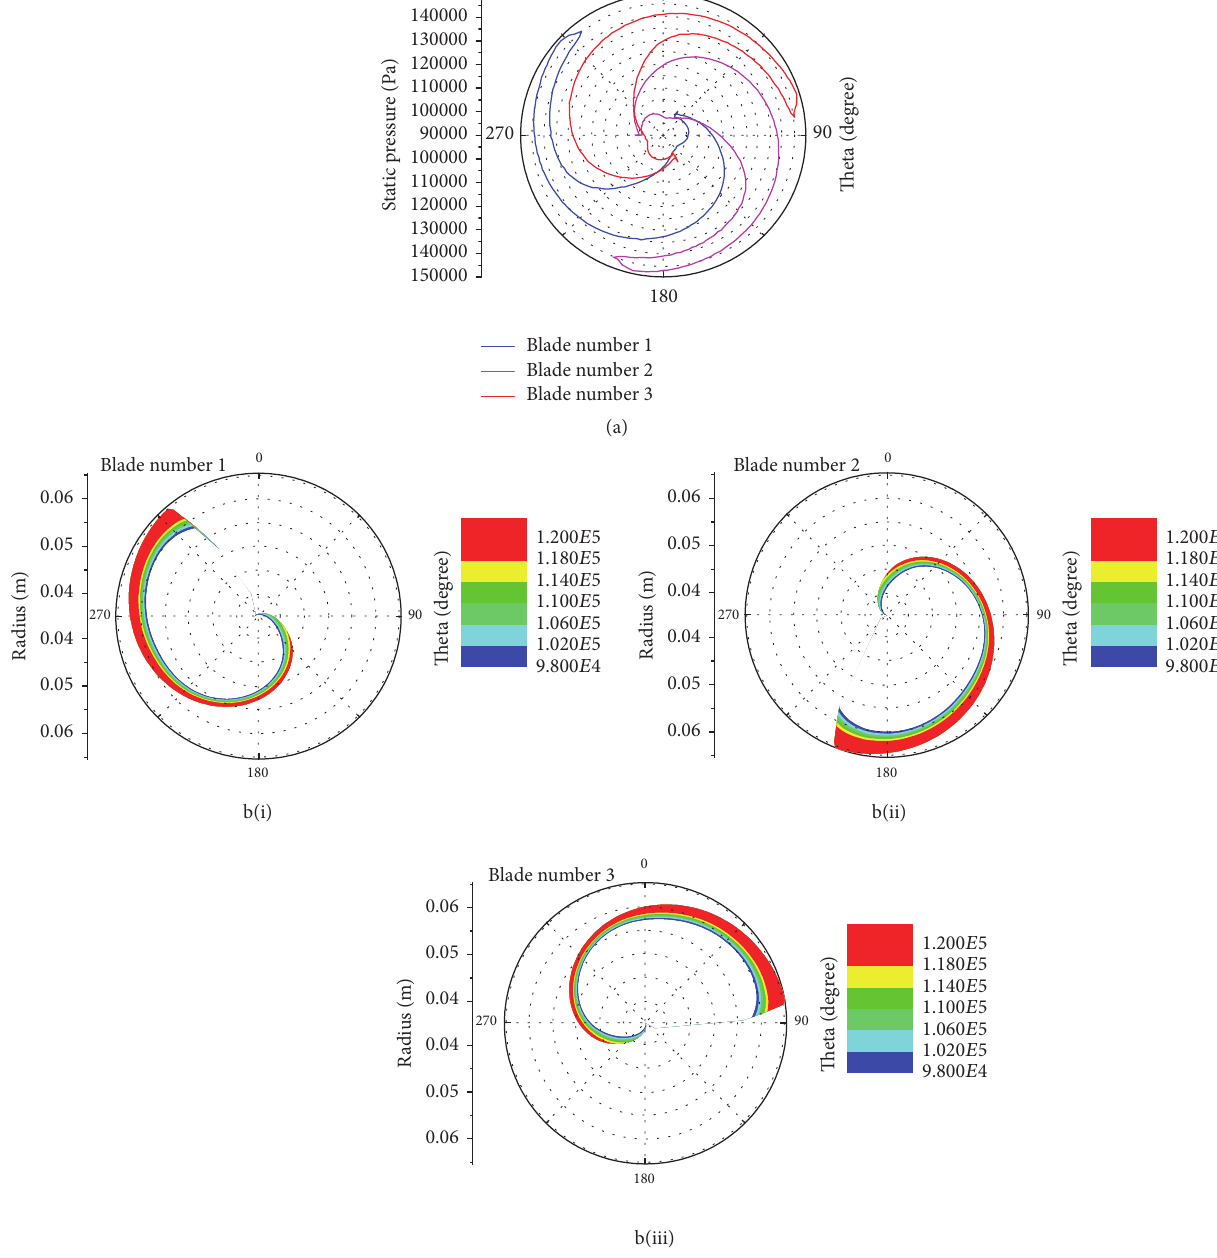
(b) The contour of static pressure distribution on each blade Figure 12: Static pressure distributions and pressure load on the blades of the inducer at 0.4 𝑄 𝑑